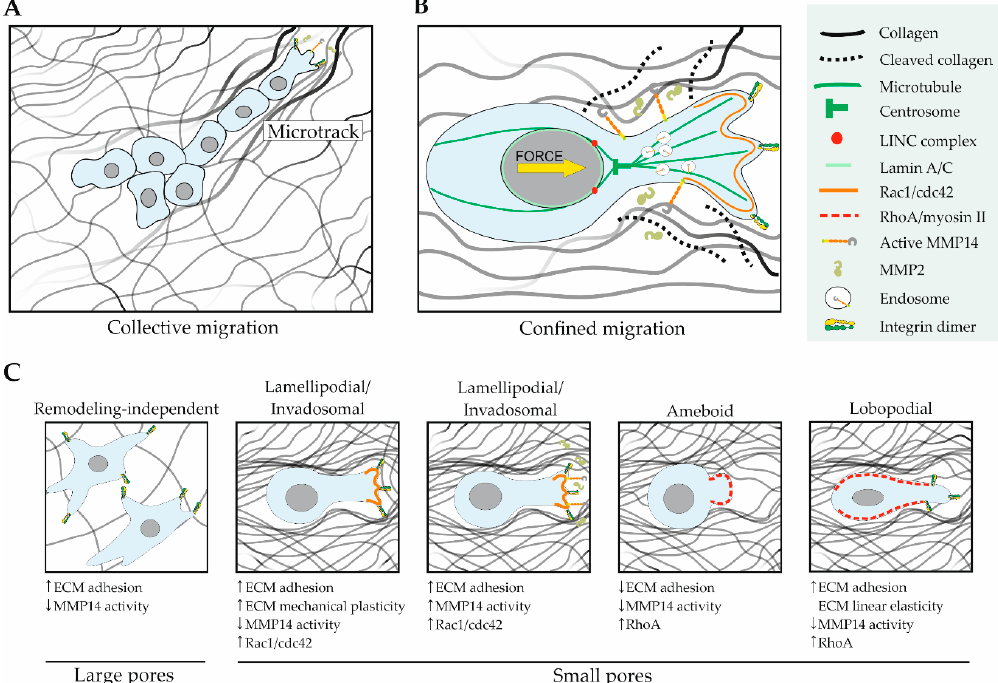
Figure 4. The structure and mechanical properties of the ECM, as well as MMP14 activity can all affect the mode of 3D cell migration. ( A ): Mesenchymal cells embedded in a dense 3D collagen matrix migrate collectively due to the formation of microtracks initiated by the MMP14-dependent collagenolysis first induced by leader cells. ( B ): In mesenchymal cells migrating in matrices with small pores (confined environment), MMP14-rich endosomes are polarized in front of the nucleus to direct the matrix degradation pericellularly towards the direction of the migration enabling the formation of pores wider than the cell nucleus. This endosome polarization depends on the LINC complex and the positioning of the centrosome ahead of the nucleus. ( C ): The type of 3D cell migration depends on characteristics of the matrix such as pore size and its elasticity and plasticity but also depend on cellular features such as the activity of MMP14, and that of the Rho GTPases Rac1, cdc42 impacting on the formation of invadopodia and matrix degradation, and RhoA inducing myosin II-dependent contractility.